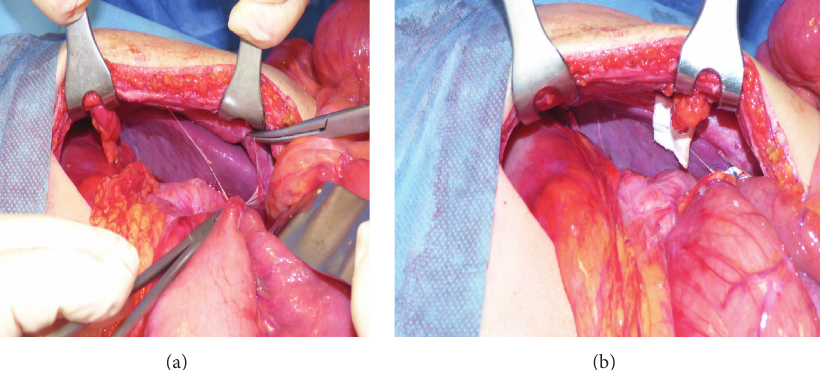
Figure 5: The splenopexy is performed by creation of a retroperitoneal pocket (a) and fixation of the spleen with nonabsorbable sutures mounted on small Teflon pledgets